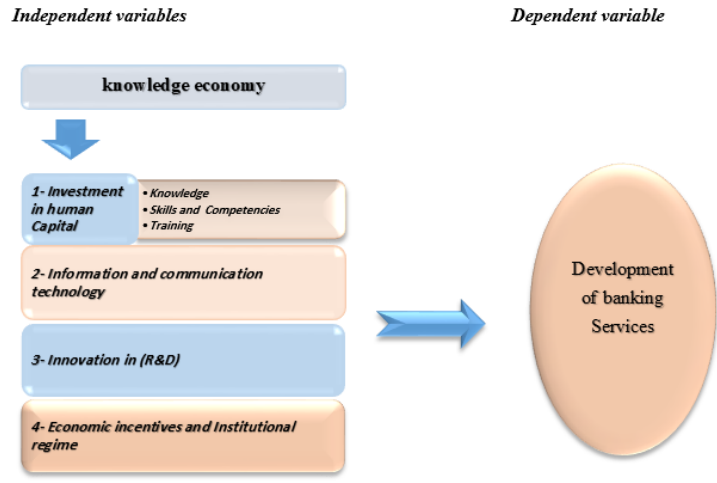
Figure 1: Model of